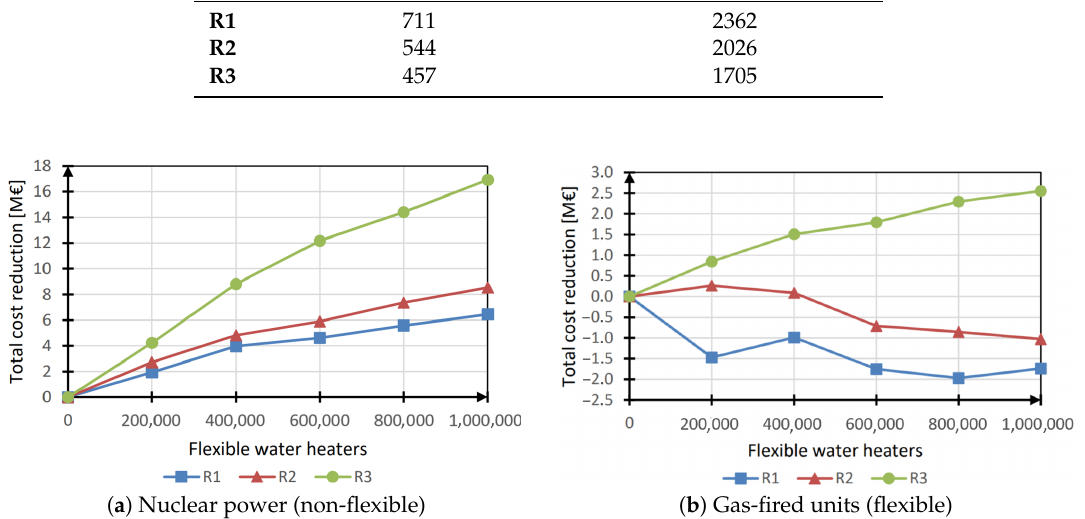
Figure 5. Total cost reduction (water